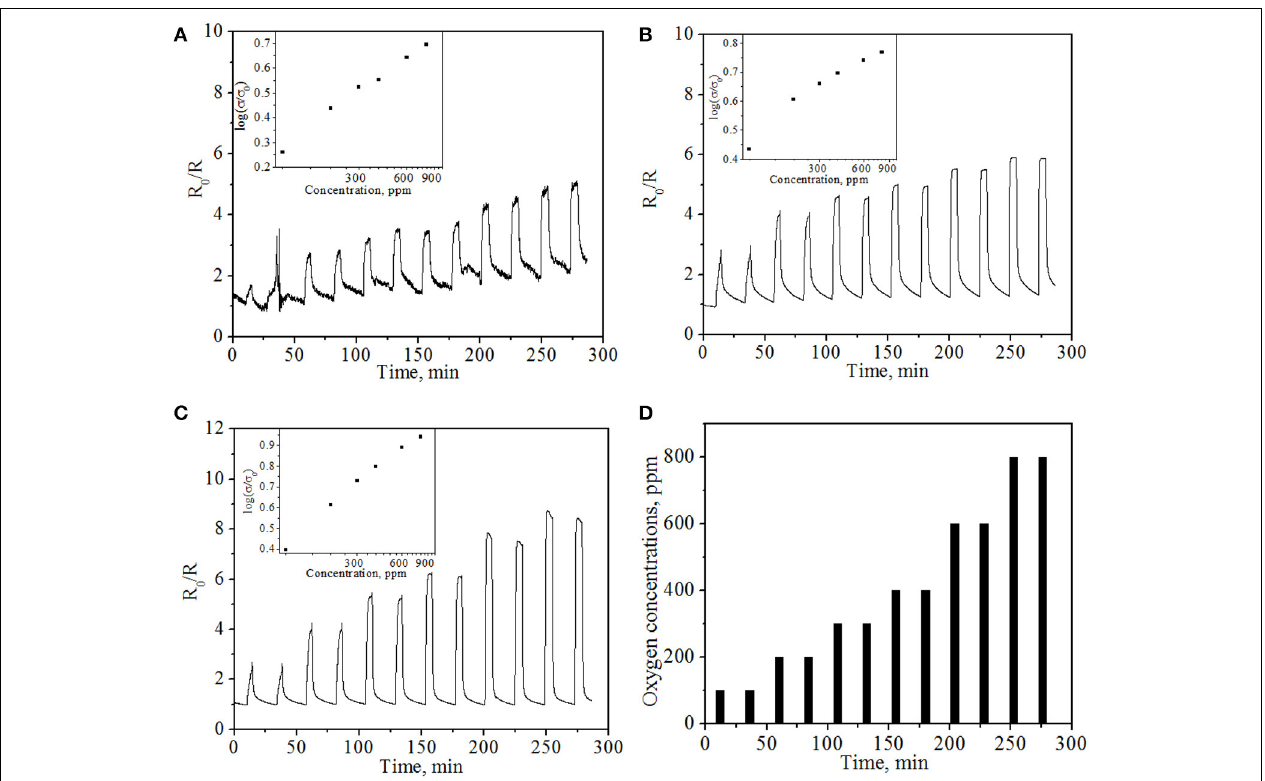
electrical conductivity of the sensor vs. oxygen concentration. (D) The pattern of supplied oxygen with various concentrations in the oxygen gas sensing